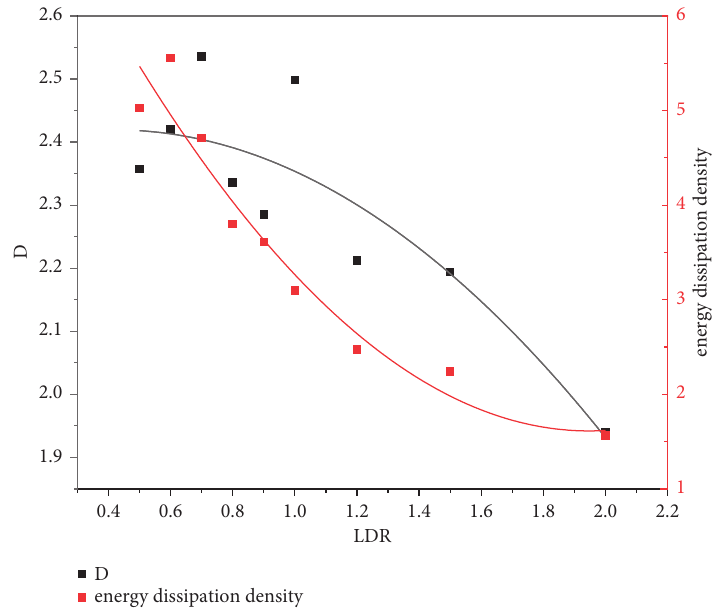
Figure 8: Correlation between specimen fractal dimension and specimen length-to-diameter ratios.